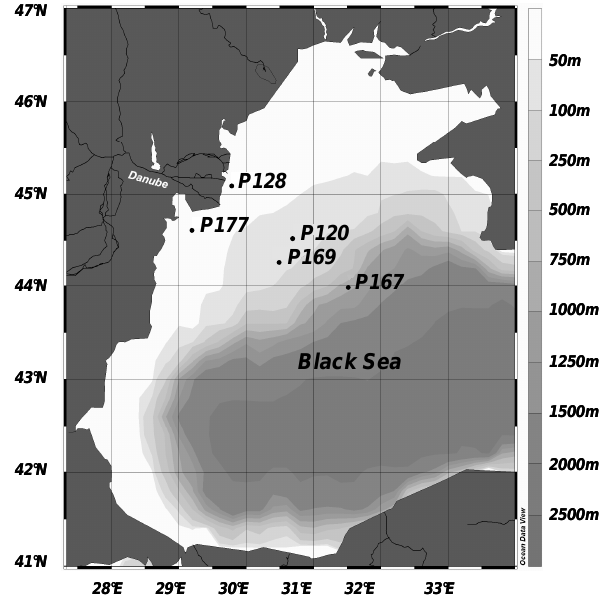
Figure 1. Locations of sampling stations. 3 Fig. 1. Locations of sampling 4